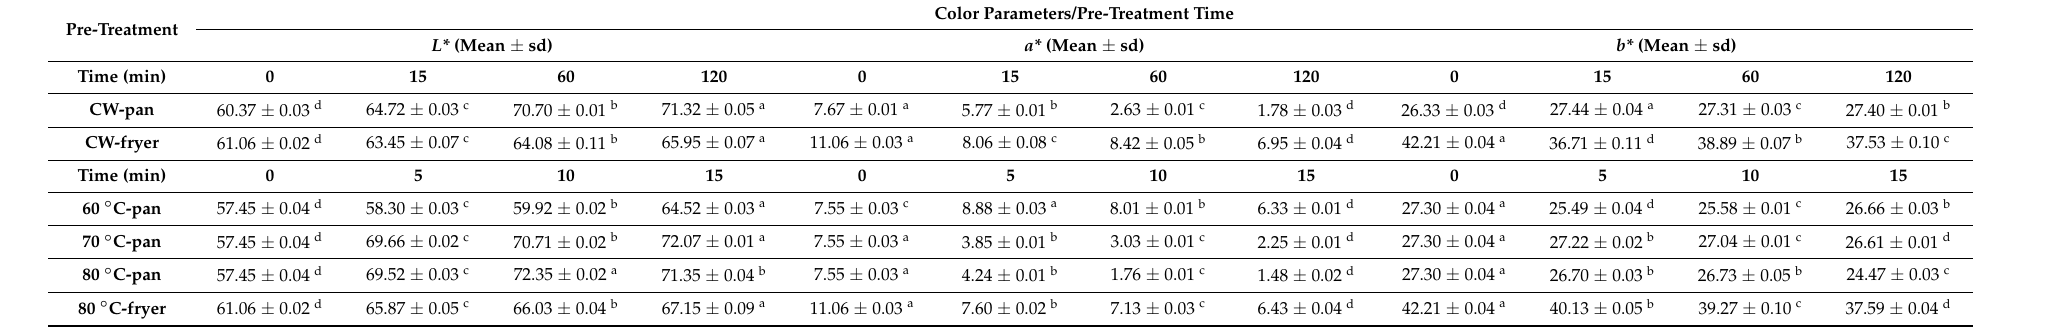
Table 3. Color parameters ( L* , a* , b* ) of French fries pre-treated with water.